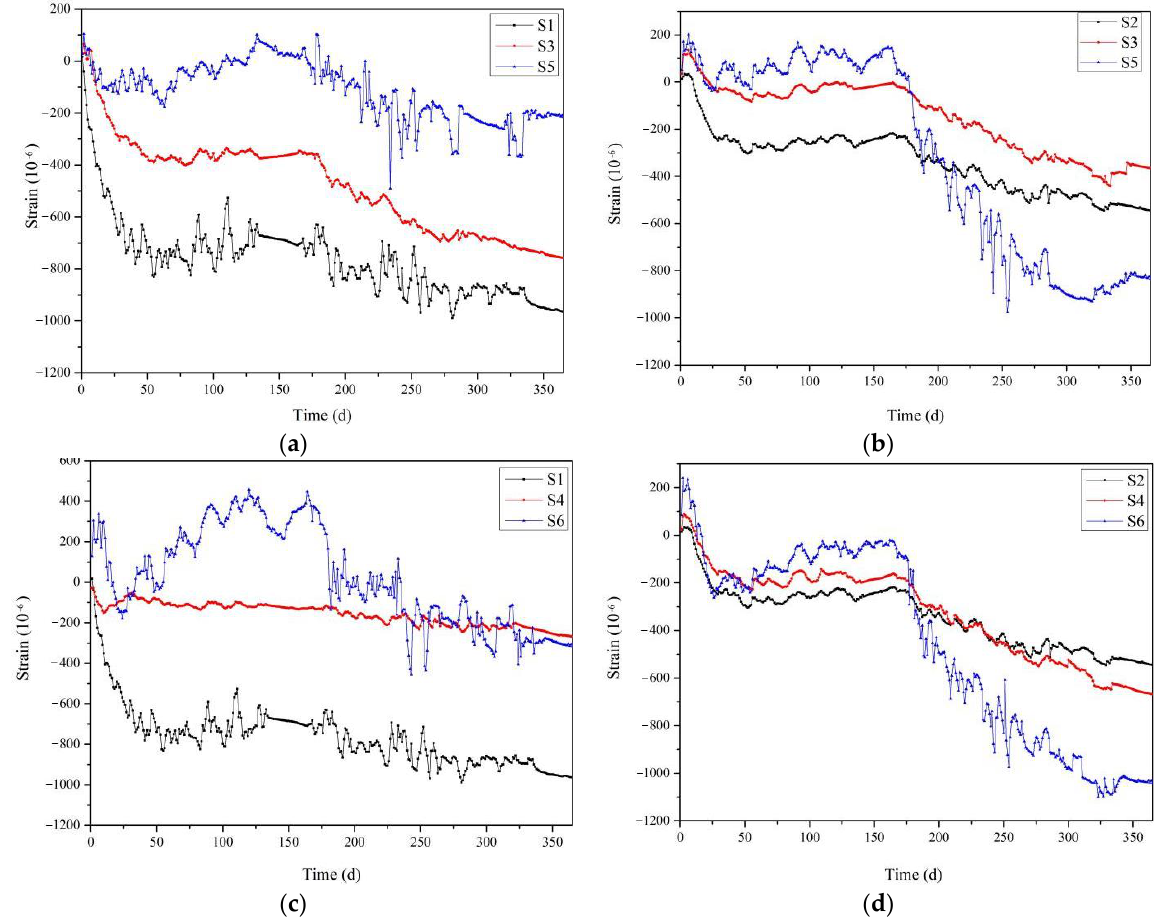
Figure 12. Strain curves for wall panels in different environments: ( a ) GRC strain curves of S1, S3, and S5; ( b ) PC strain curves of S2, S3, and S5; ( c ) GRC strain curves of S1, S4, and S6; ( d ) PC strain curves of S2, S4, and S6.